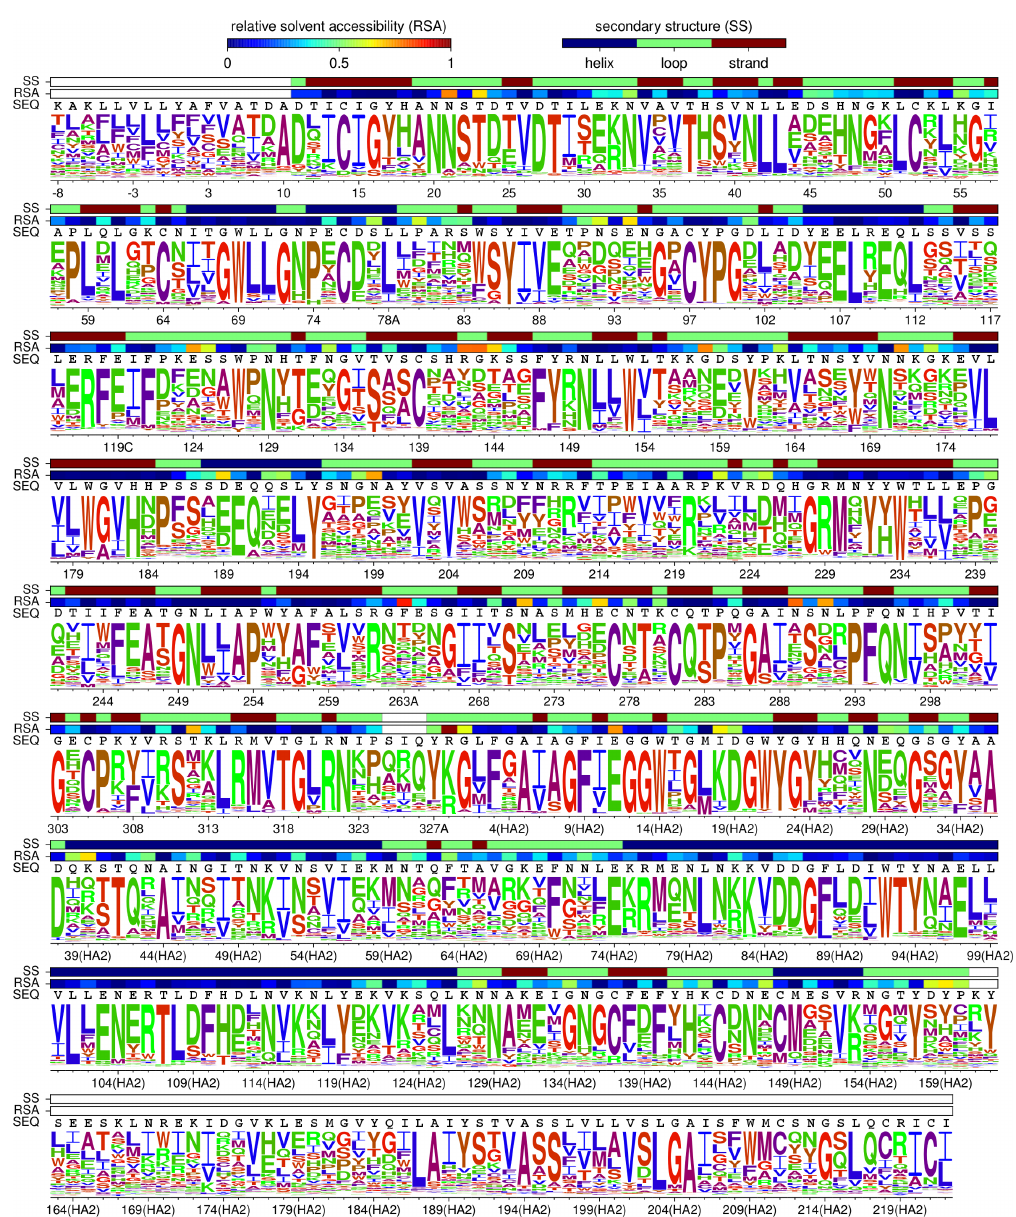
Figure 3. HA’s site-specific amino-acid preferences. The preference of each site in HA for each of the 20 amino-acids as inferred by combining the new and old data and re-scaling by the stringency parameter inferred in Table 1. The height of each letter is proportional to the preference for that amino acid at that site. The overlay bars show each residue’s secondary structure, relative solvent accessibility, and wildtype identity in the A/WSN/1933 HA. Amino acids are colored according to hydrophobicity using a blue-to-red-to-green scale (most hydrophobic is blue , most hydrophilic is green ). The sequence is numbered using the H3 numbering scheme. Conversion between WSN sequential numbering and H3 numbering is provided in File